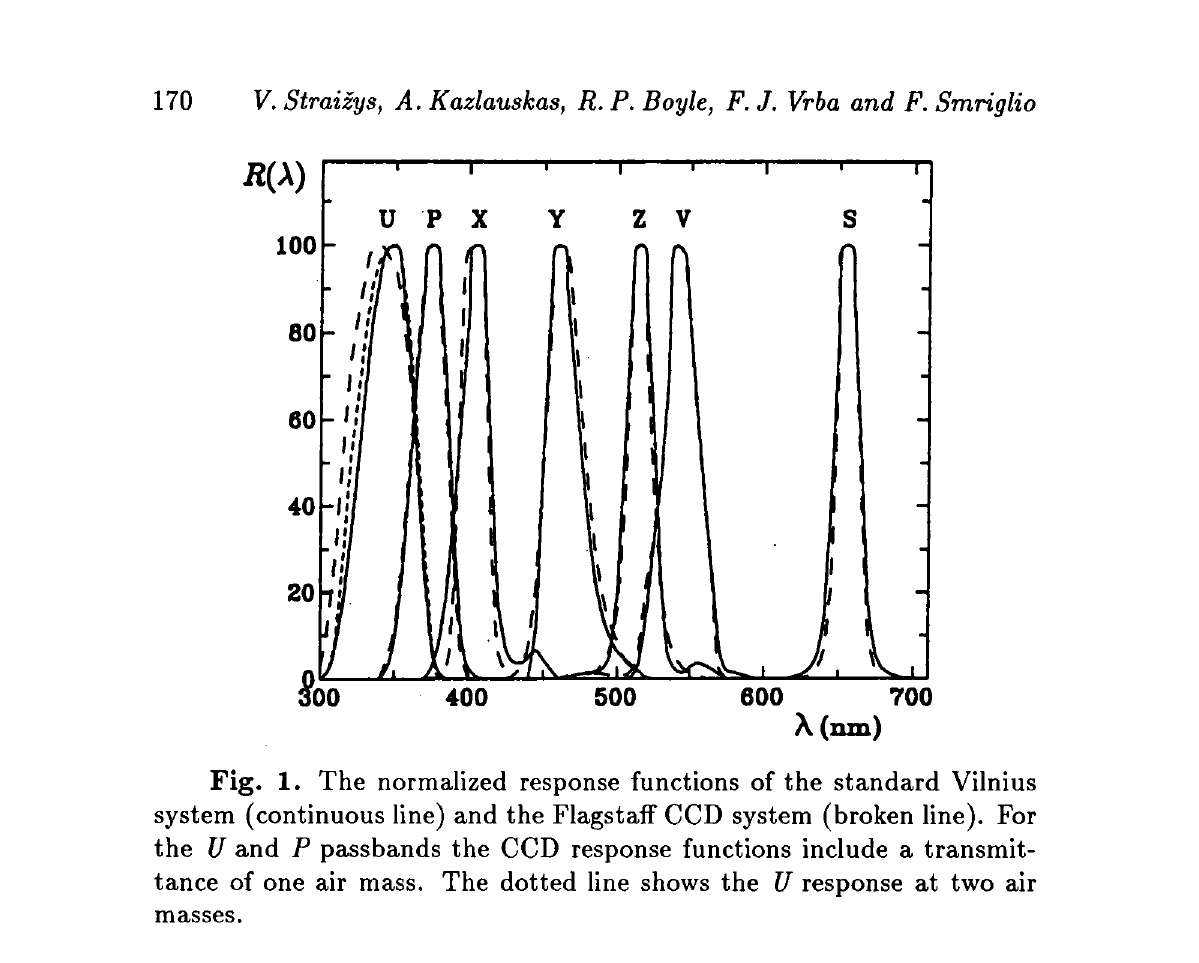
Fig. 1. The normalized response functions of the standard Vilnius system (continuous line) and the Flagstaff CCD system (broken line). For the U and P passbands the CCD response functions include a transmit- tance of one air mass. The dotted line shows the U response at two air